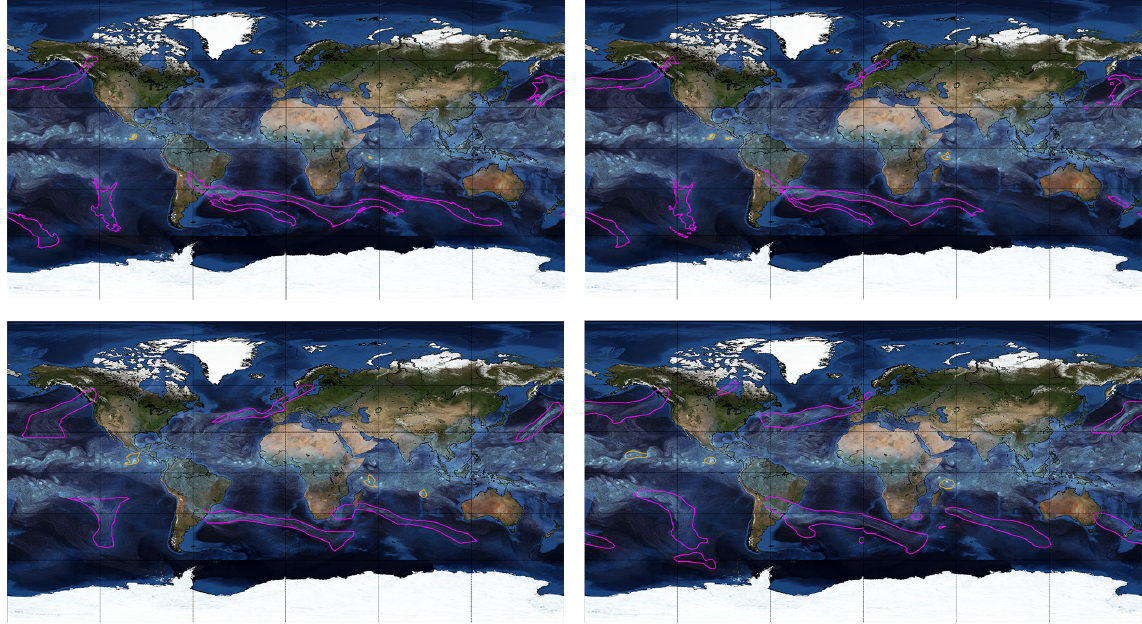
Figure 6. Comparison of labels from TECA (top left), model predictions trained on TECA (top right), the ClimateNet dataset (bottom left), and model predictions trained on ClimateNet (bottom right). The “bluemarble” map in the background included via Matplotlib’s Basemap library is © NASA.